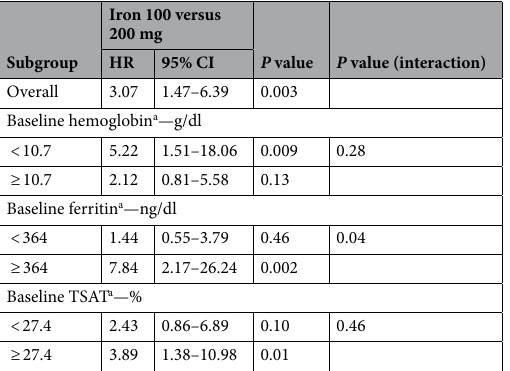
Table 4. Subgroup analyses by baseline hemoglobin, ferritin, and transferrin saturation to determine the first withholding intravenous iron events between 100-mg and 200-mg intravenous iron groups. Cox proportional hazard model is used in all subgroup analyses. TSAT, transferrin saturation; HR, hazard ratio. a Cutoff point of each parameter is selected by median